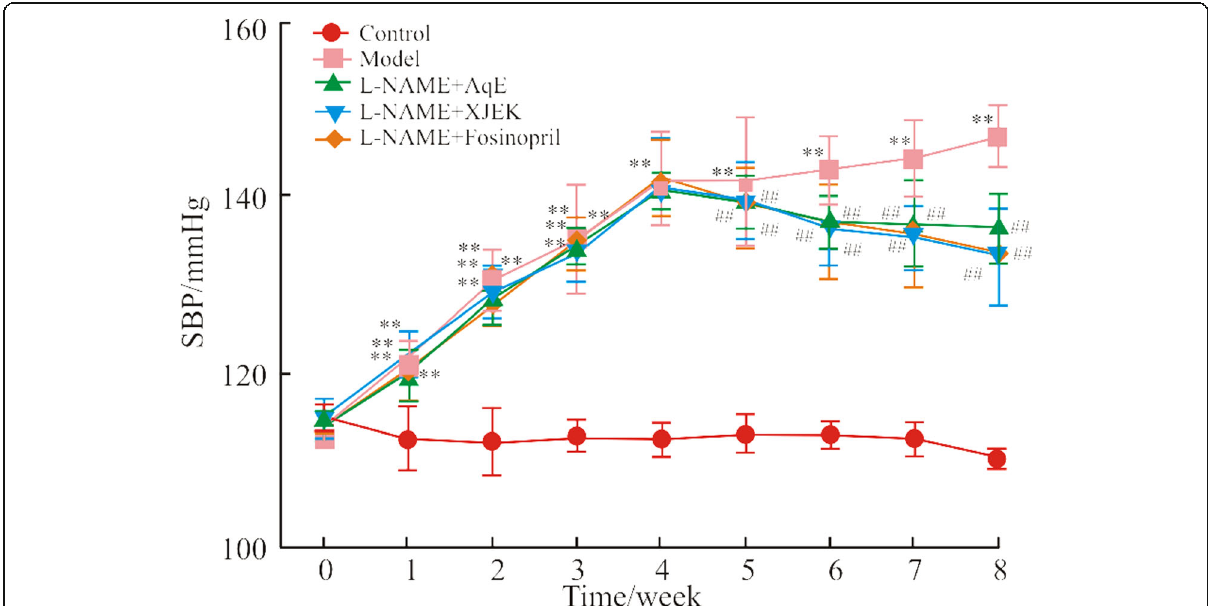
Fig. 3 Development of SBP in five groups in an 8-week period. SBP was measured in each group at nine time points using tail-cuff apparatus. The hypertensive response to L -NAME administration was time-dependent, reaching a maximum in week 8. AqE was efficacious in inhibiting the development of high blood pressure at week 5 of treatment with L -NAME, which was significantly different compared with the model group. Data are presented as the mean ± SD ( n = 10). ** P < 0.01 vs. control group; ## P < 0.01vs. model group